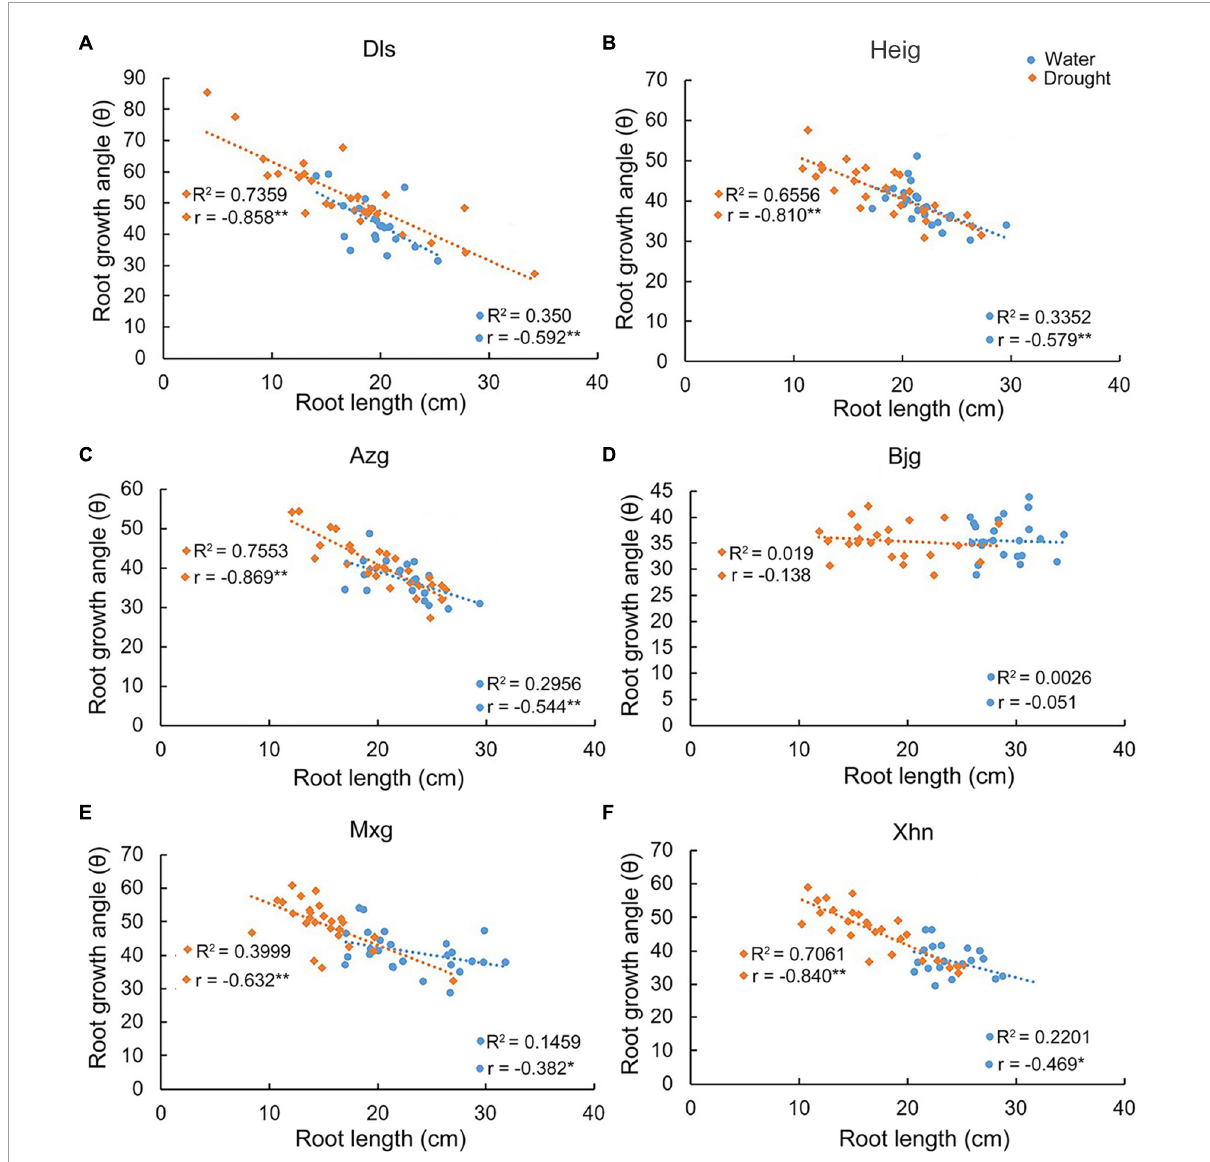
FIGURE3 Correlations between root growth angles and root lengths in different rice varieties. The correlation between root lengths and root growth angles in six rice varieties shown in Figures 1A–L were analyzed by using SPSS software. R 2 , determination coefficient; r, Pearson’s correlation coefficient; r < 0, negative correlation; * P < 0.05, ** P < 0.01 (SPSS analysis) (A–F) . Water, rice seedlings grown under irrigation condition; Drought, rice seedlings grown under drought condition; Dls, Da Leng Shui; Heig, Hei Gu; Azg, Ai Zhe Gu; Bjg, Ban Jiu Gu; Mxg, Ma Xian Gu; Xhn, Xiao Hua